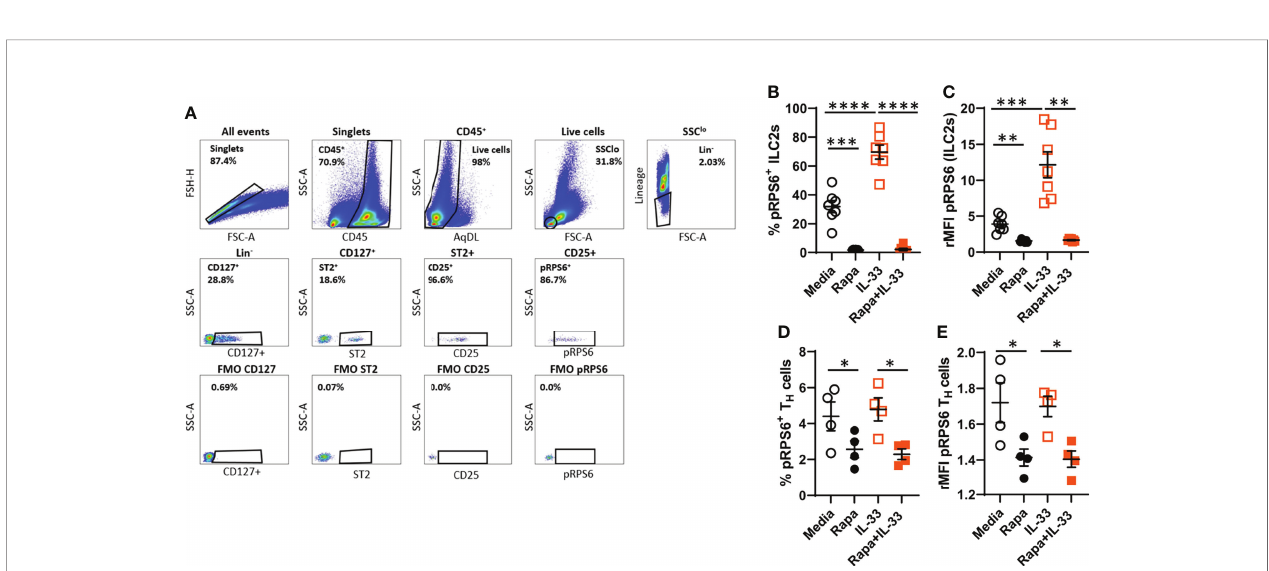
FIGURE 3 | IL-33 induced high mTORC1 activity in bone marrow ILC2s ex vivo . (A) Gating strategy for quantifying mTOR activity in ILC2s measured by pRPS6 after IL-33 stimulation of cultured bone marrow cultures. (B) Number of pRPS6 + ILC2s and (C) pRPS6 intensity in ILC2s measured by relative mean fl uorescence intensity (rMFI). (D) Number of pRPS6 + T H cells and (E) pRPS6 intensity in T H cells measured rMFI. Data are representative of 1 – 2 independent experiments (4 – 7/group). Paired Student ’ s t-test. *P < 0.05, **P < 0 .01, ***P < 0.001 and ****P < 0.0001. Rapa,